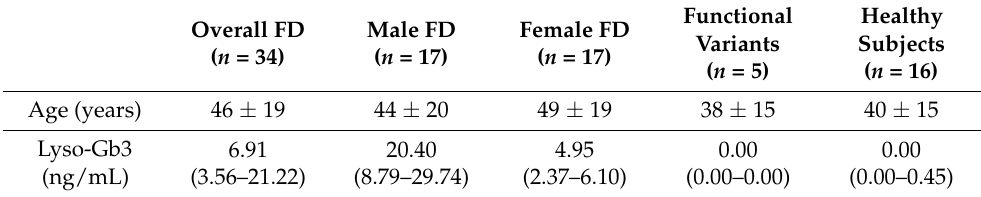
Table 3. Demographic and clinical characteristics of